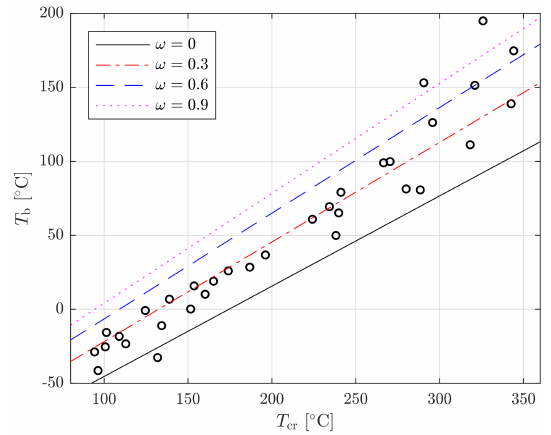
Figure 4. Critical temperature T cr and boiling temperature T b of common working fluids available within the REFPROP program (circles) and the same parameters obtained using the Peng–Robinson equation of state for different values of ω with p cr = 30 bar (lines).